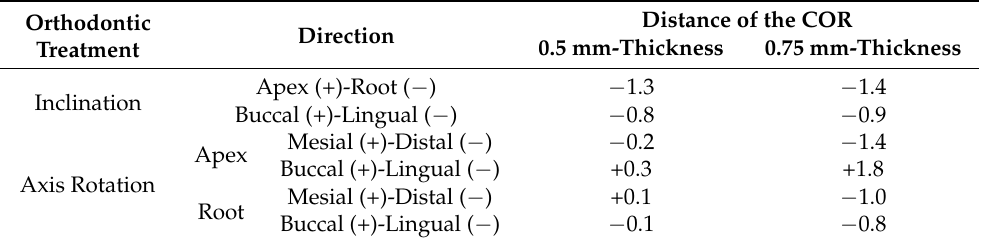
Table 2. The location change of the center of rotation (COR) values (mm) after orthodontic finite element analysis (FEA) in two orthodontic treatment situations. (Origin position: COR in orthodontic treatment